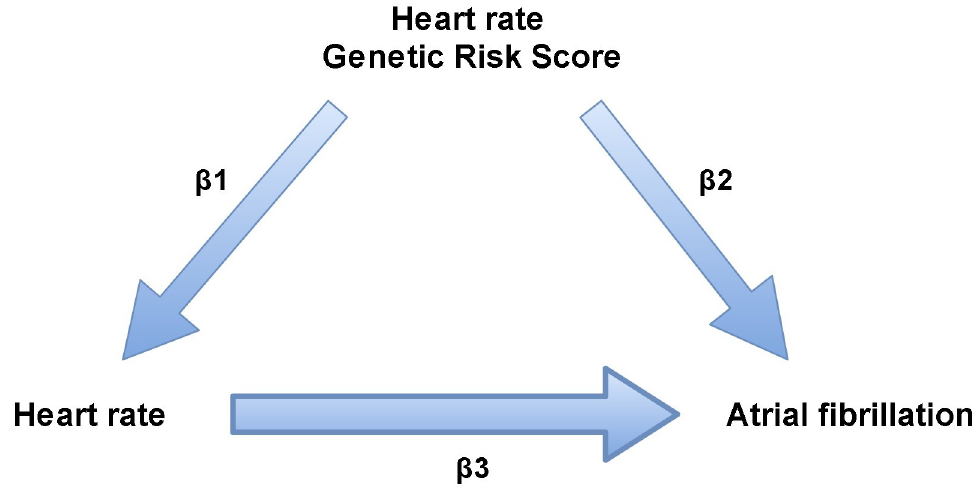
Fig 2. Visualization of the ratio estimator.